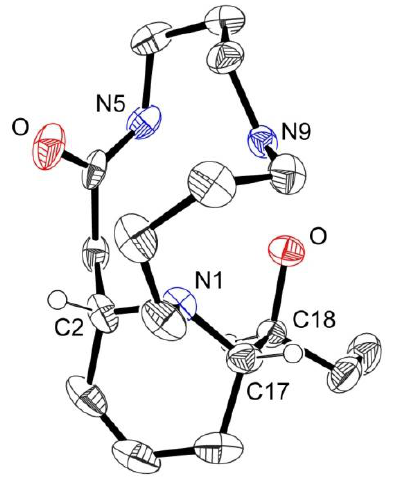
Figure 3. Perspective drawing of the X-Ray structure of compound 2a hydrochloride. Thermal ellipsoids are set at the 50% probability level. The solvent molecule, the chloride counter anion and all hydrogen atoms, except those on the chiral carbons, have been omitted for